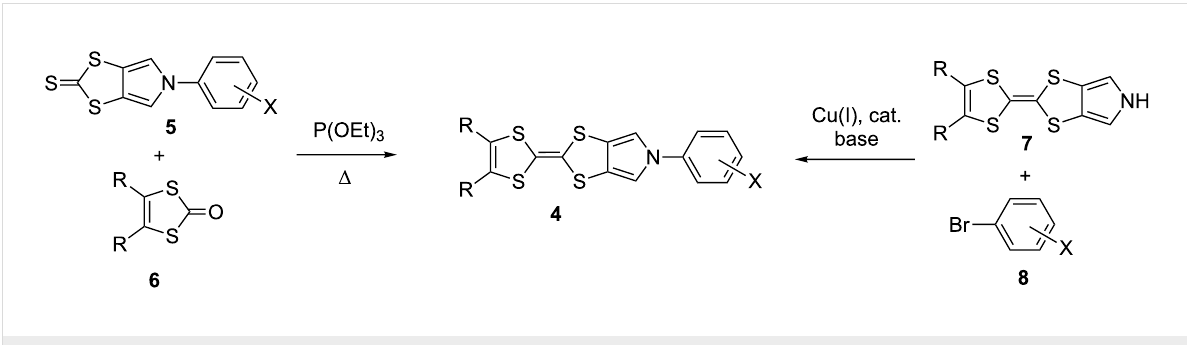
Scheme 1: The two synthetic approaches used for the preparation of arylated monopyrrolotetrathiafulvalenes 1 .